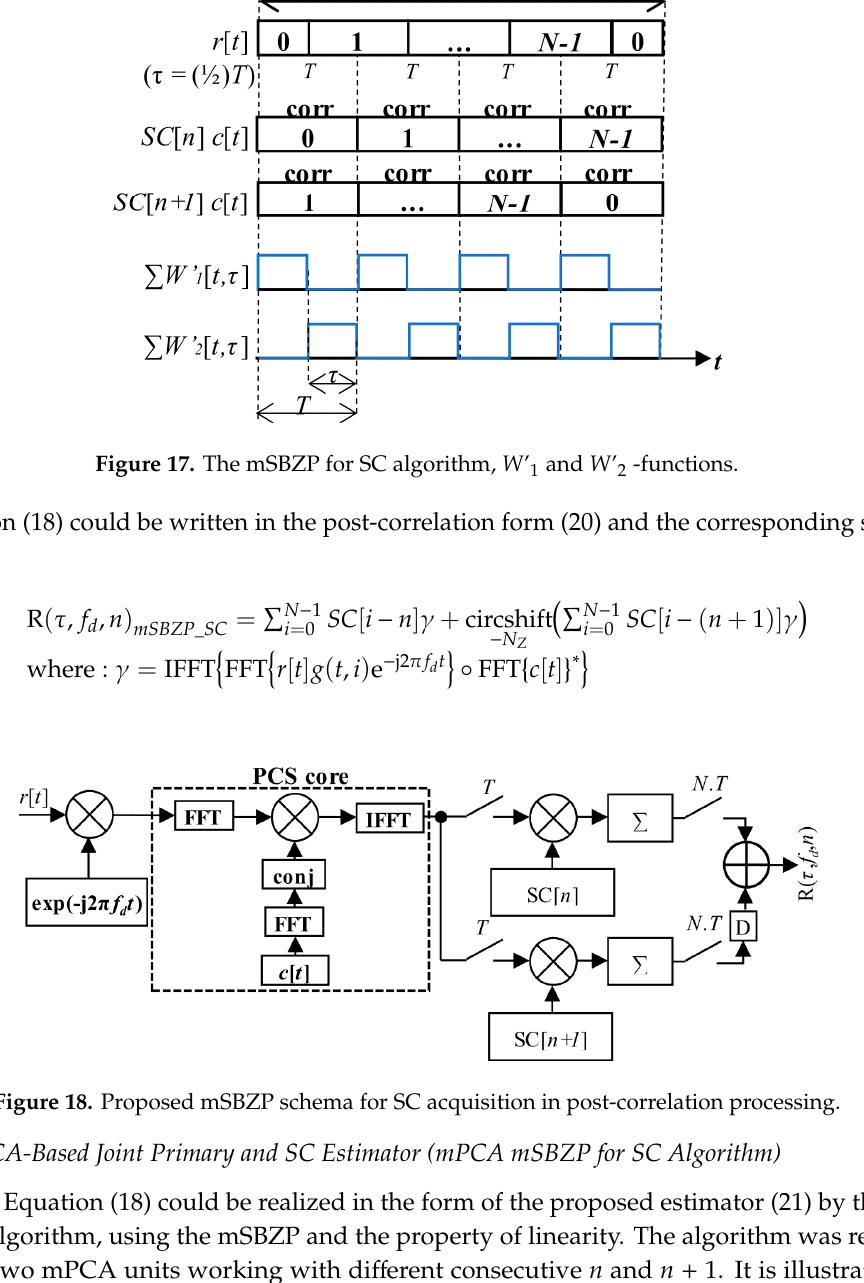
Figure 18. Proposed mSBZP schema for SC acquisition in post-correlation processing .